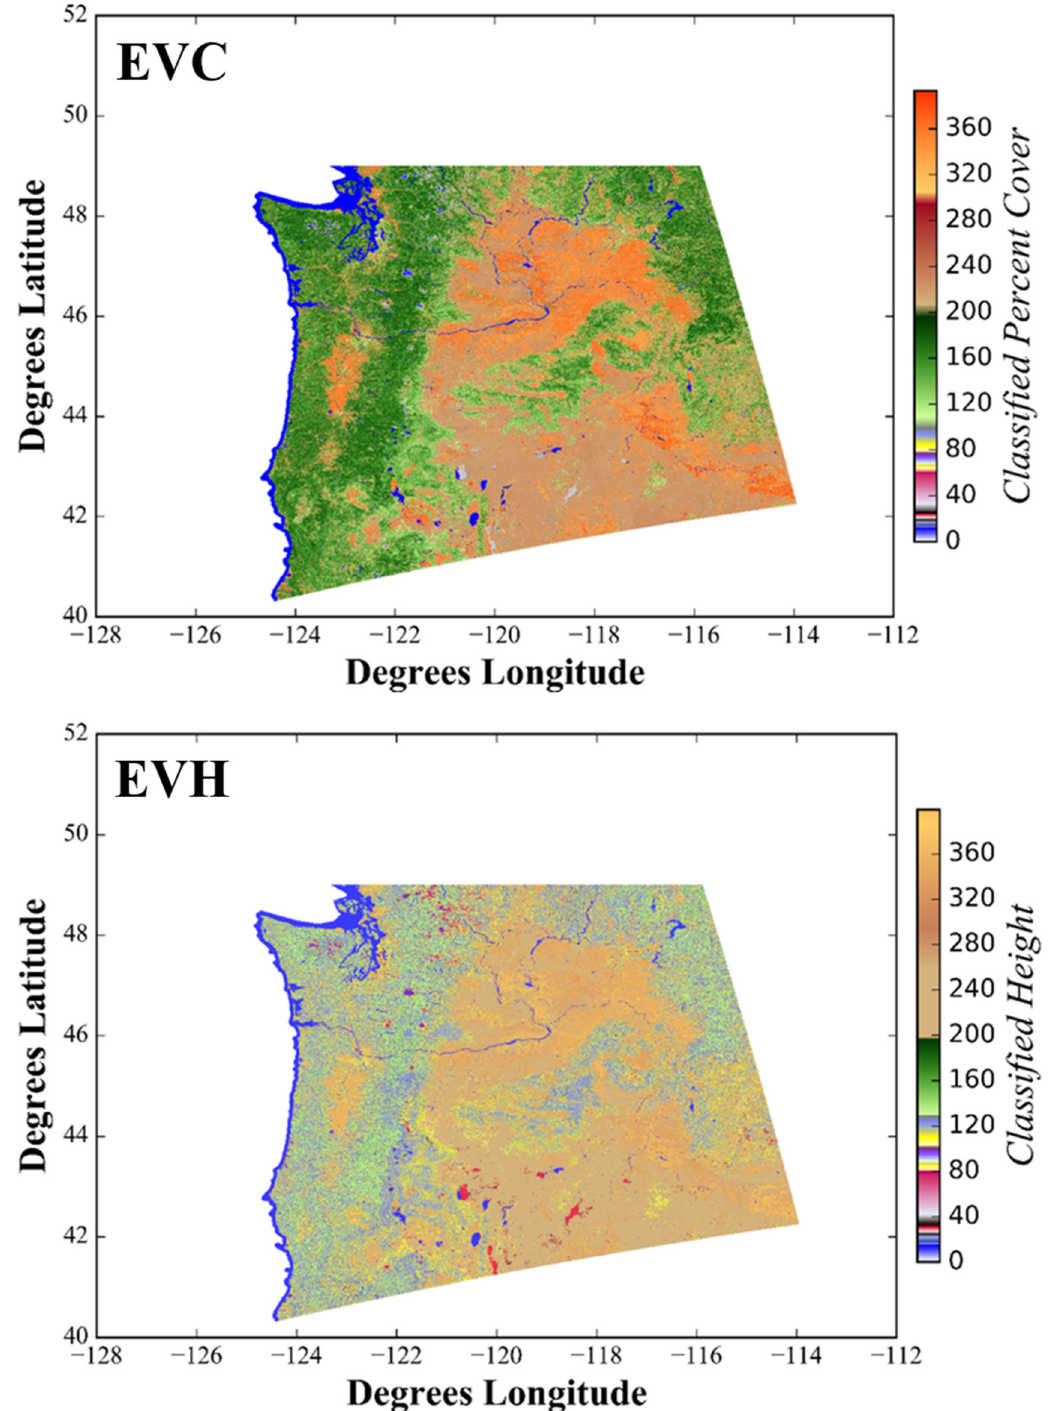
Figure 8. Existing Vegetation Cover (EVC) classified percent cover and Existing Vegetation Height (EVH) products within the Pacific Northwest prototype area. Both EVC and EVH are classified by lifeform values with values of 100s, 200s, and 300s representing tree, herb, and shrub classes, respectively. EVC values in percent cover can be calculated by subtracting 100, 200, or 300 from the value. EVH can be calculated the same way as EVC, although values are in meters (tree), centimeters (shrub), and decimeters (herb). All values below 100 are specific thematic classes (e.g., water, value = 11).